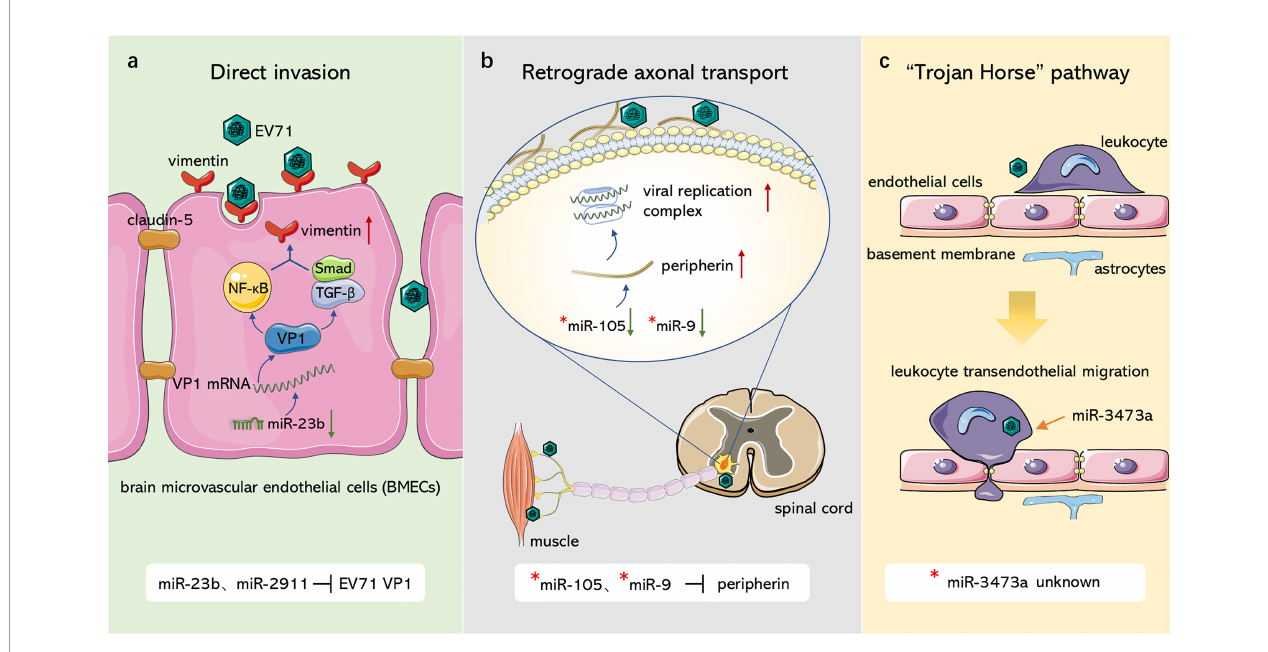
FIGURE 1 | Role of ncRNAs in EV71 invasion through blood-brain barrier. (A) Direct invasion. miR-23b and miR-2911 downregulate junction protein claudin-5 and upregulate EV71 receptor vimentin, resulting in damage to blood-brain barrier and the attachment of EV71 through modulating VP1 expression. (B) Retrograde axonal transport. miR-105 and miR-9 can target peripherin, which facilitates EV71 attachment and replication, to modulate viral retrograde axonal transport. (C) “ Trojan Horse ” pathway. EV71 can hijack immune cells to intrude CNS, miR-3473a may mediate leukocyte trans-endothelial migration and induce BBB disruption associated with EV71. “ * ” : non-EV71-infected disease